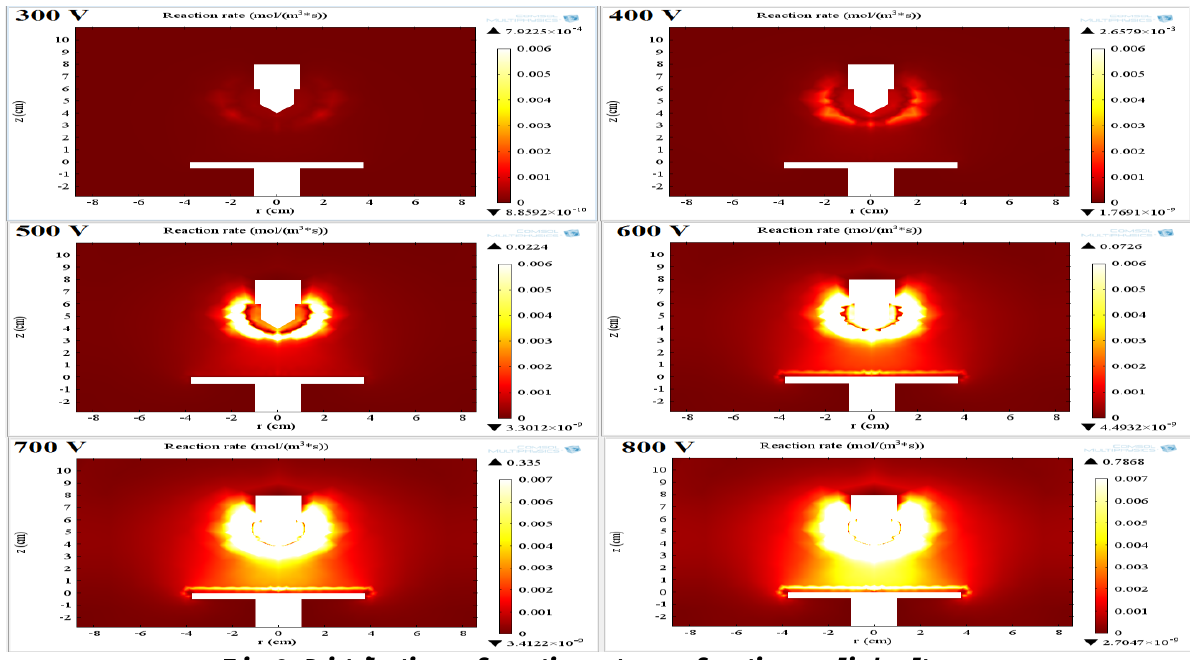
Fig. 9: Distributions of reaction rate as a function applied